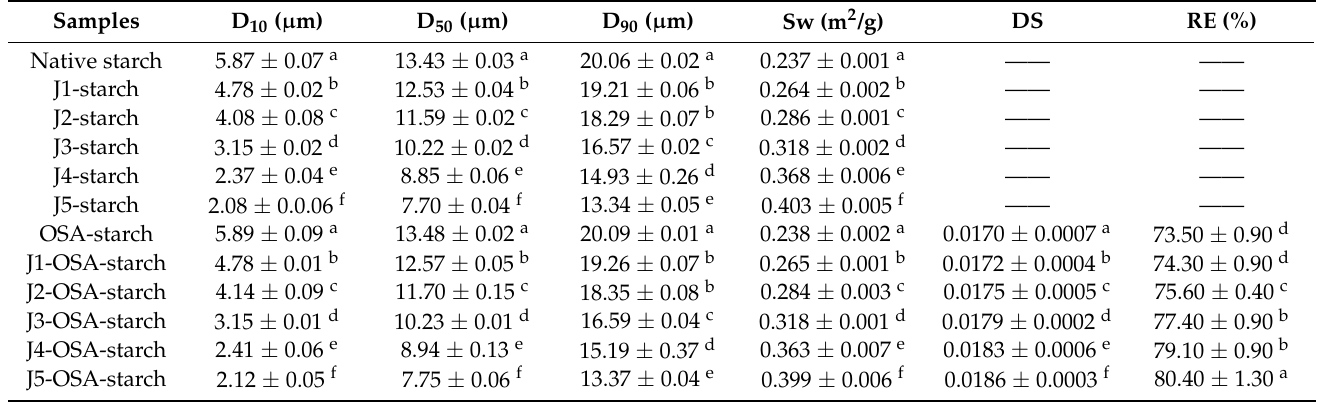
Table 1. Particle size parameters, degree of substitution, and reaction efficiency of J-starch and